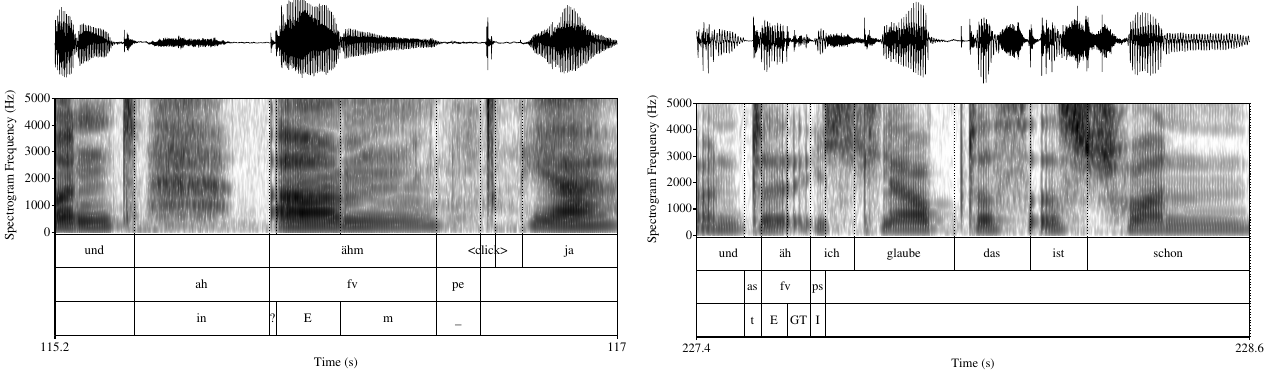
Figure 2. Left panel: Filler particle ähm in und <ah: breathing in> ähm <pe: pause> <click> <pause> ja ‘and <...> ähm <...> yes’ constituting a single intonation unit between a breath (ah) and a ‘noisy’ pause (pe) (source: bi_f_free_f17 ). Right panel: Filler particle äh in und äh ich glaube das ist schon ‘and uh I believe that is already’ within an intonation unit, surrounded by phonetic segments (as, ps). The third layer consists of extended SAMPA, cf. Table 2 (source: bj_f_free_f19